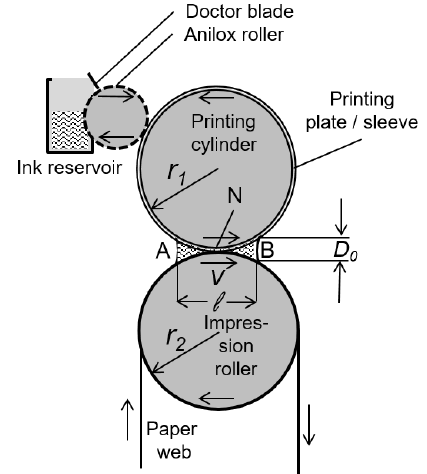
Figure 2. Principal design of a flexographic printing unit. A, B, incoming and outgoing ink meniscus; N, printing nip; D 0 , meniscus height; (cid:96) , width of the wetted